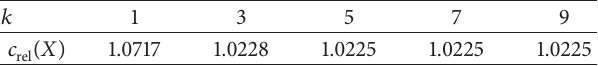
Table 4: Relative condition number for Example 17 with different values of 𝑘